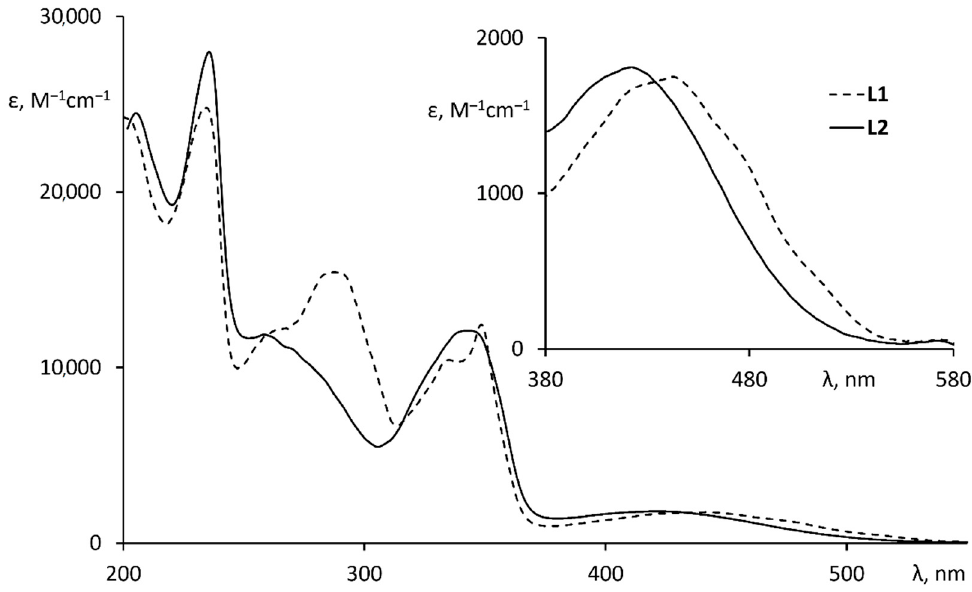
Figure 3. UV-vis spectra of L1 and L2 measured in degassed acetonitrile at 20 °C.